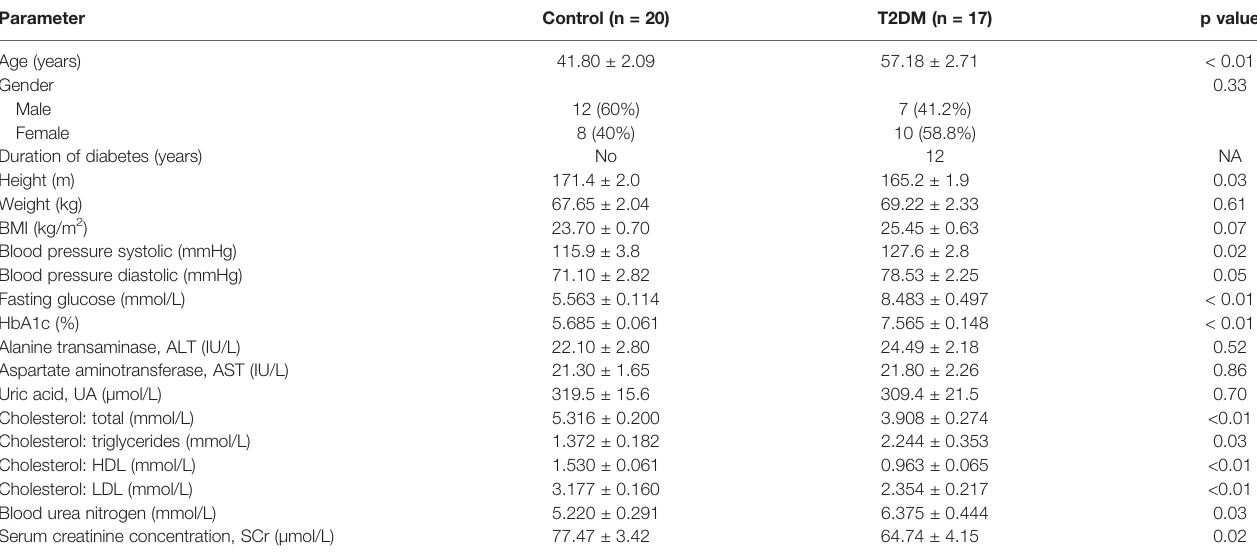
TABLE 1 | Comparison of the baseline study parameters between healthy control and T2DM.